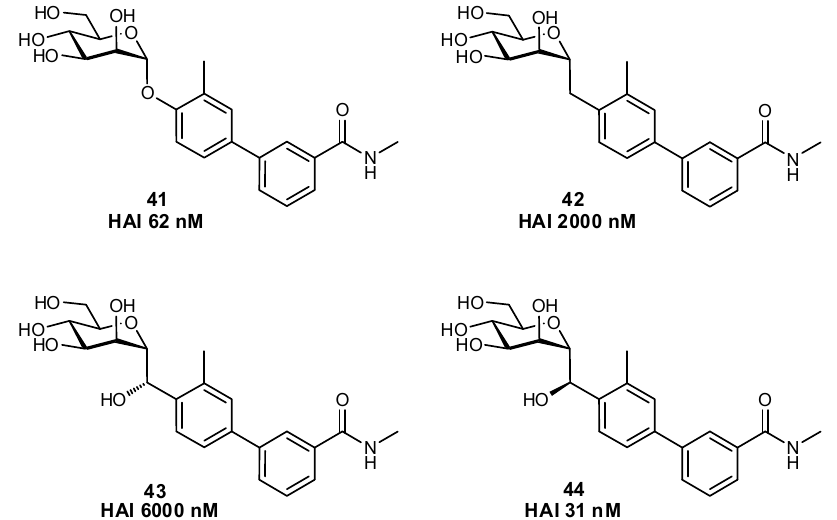
Figure 14. The development of C -glycosides for treatment of UTIs has been used to improve the metabolic stability of biaryl FimH antagonists (HAI = hemagglutination inhibition assay) [115].